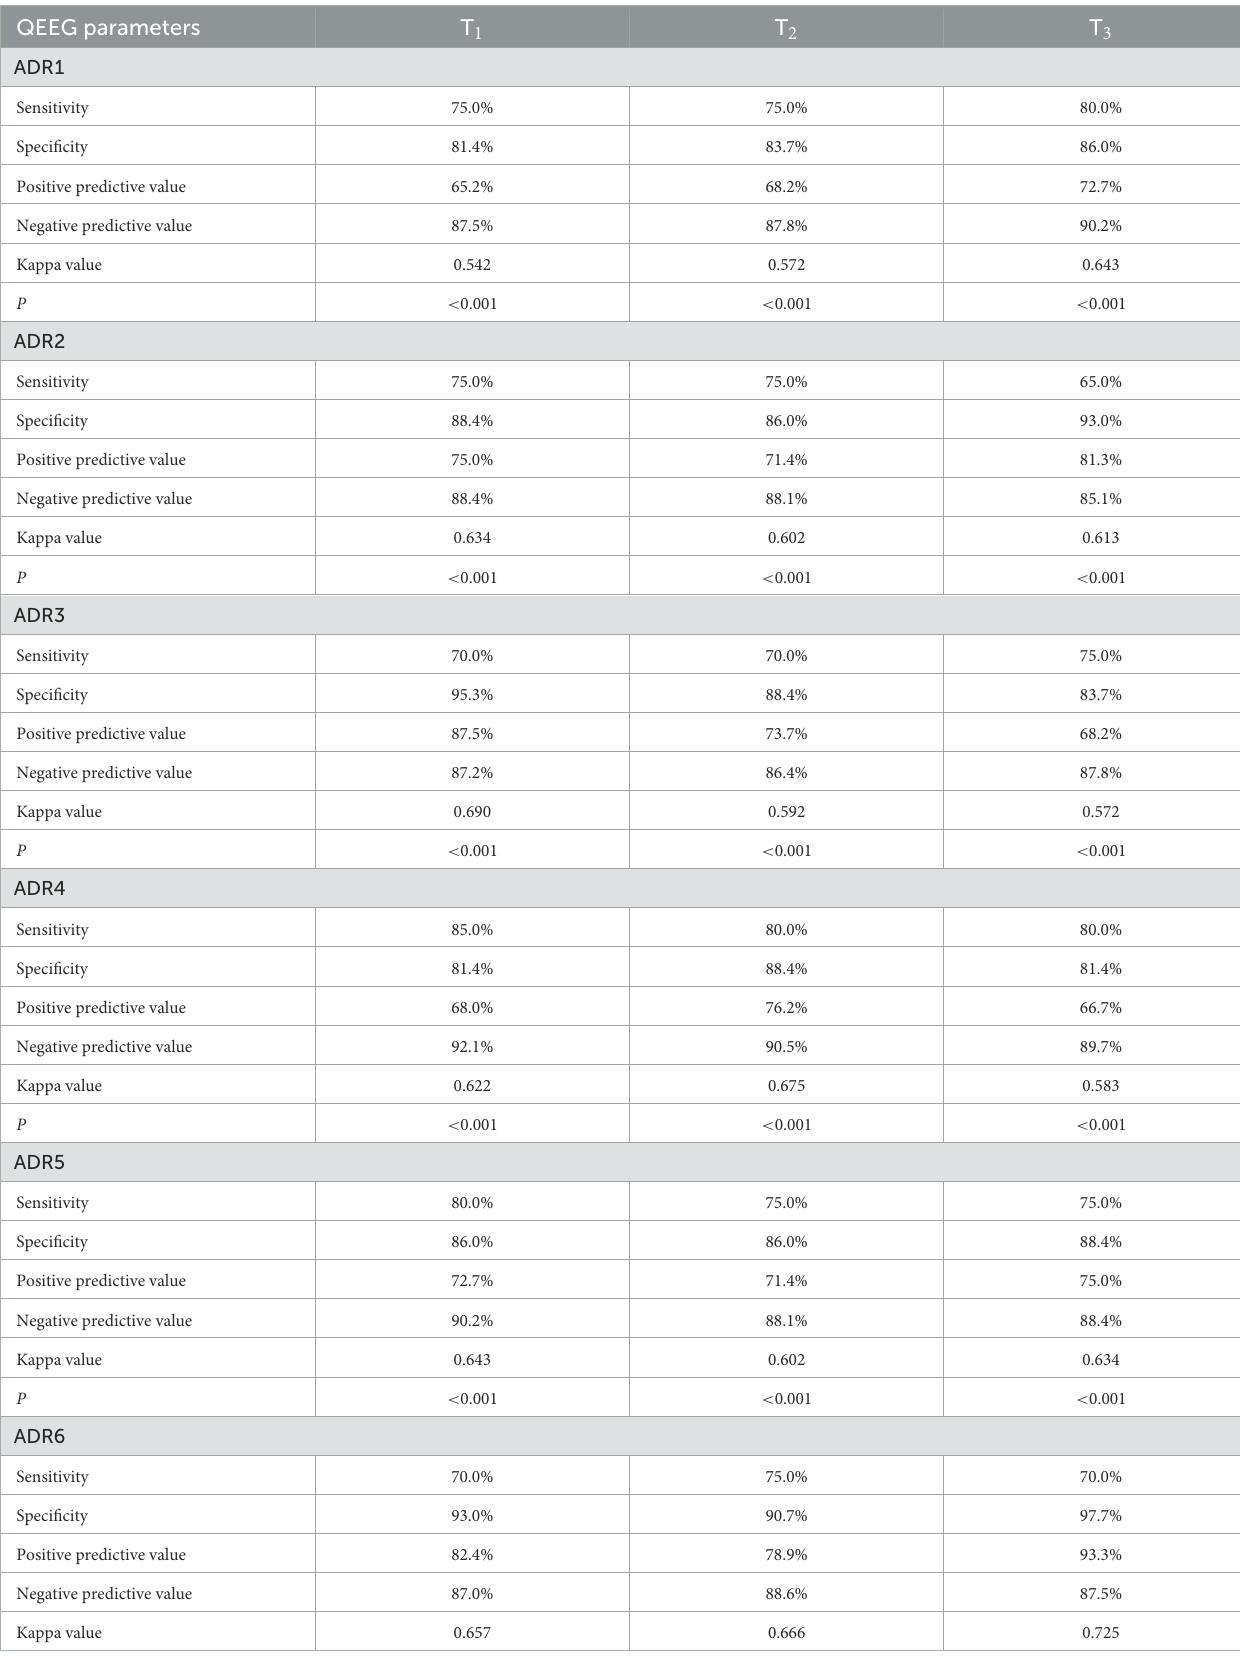
TABLE 5 The accuracy of ADR evaluation at different time points of different leads on the surgical side undergoing CEA according to the cut-off point value. QEEG parameters T